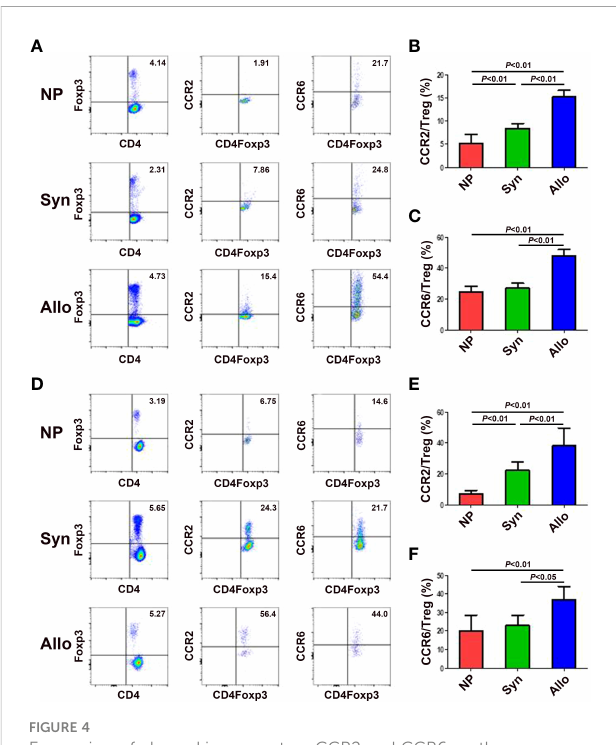
FIGURE 4 Expression of chemokine receptors CCR2 and CCR6 on thymus and blood Treg cells between syngeneic and allogeneic mice. (A) Representative fl ow cytometry experiments of the levels of CCR2 and CCR6 on thymus Treg cells are shown. Levels of CCR2 (B) and CCR6 (C) on thymus Treg cells are shown. (D) Representative fl ow cytometry experiments of the levels of CCR2 and CCR6 on peripheral blood Treg cells are shown. Levels of CCR2 (E) and CCR6 (F) on peripheral blood Treg cells are shown. Data are presented as mean ± SD (n = 6). NP, non-pregnant group; Syn, syngeneic pregnant group; Allo, allogeneic pregnant